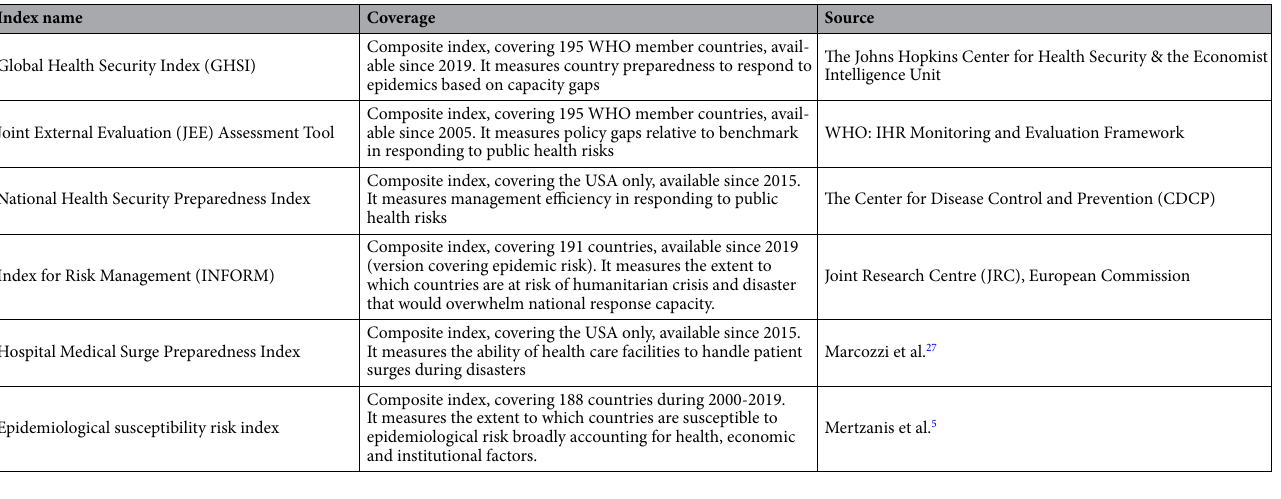
Table 1. Comparison of alternative measures of country preparedness to epidemiological